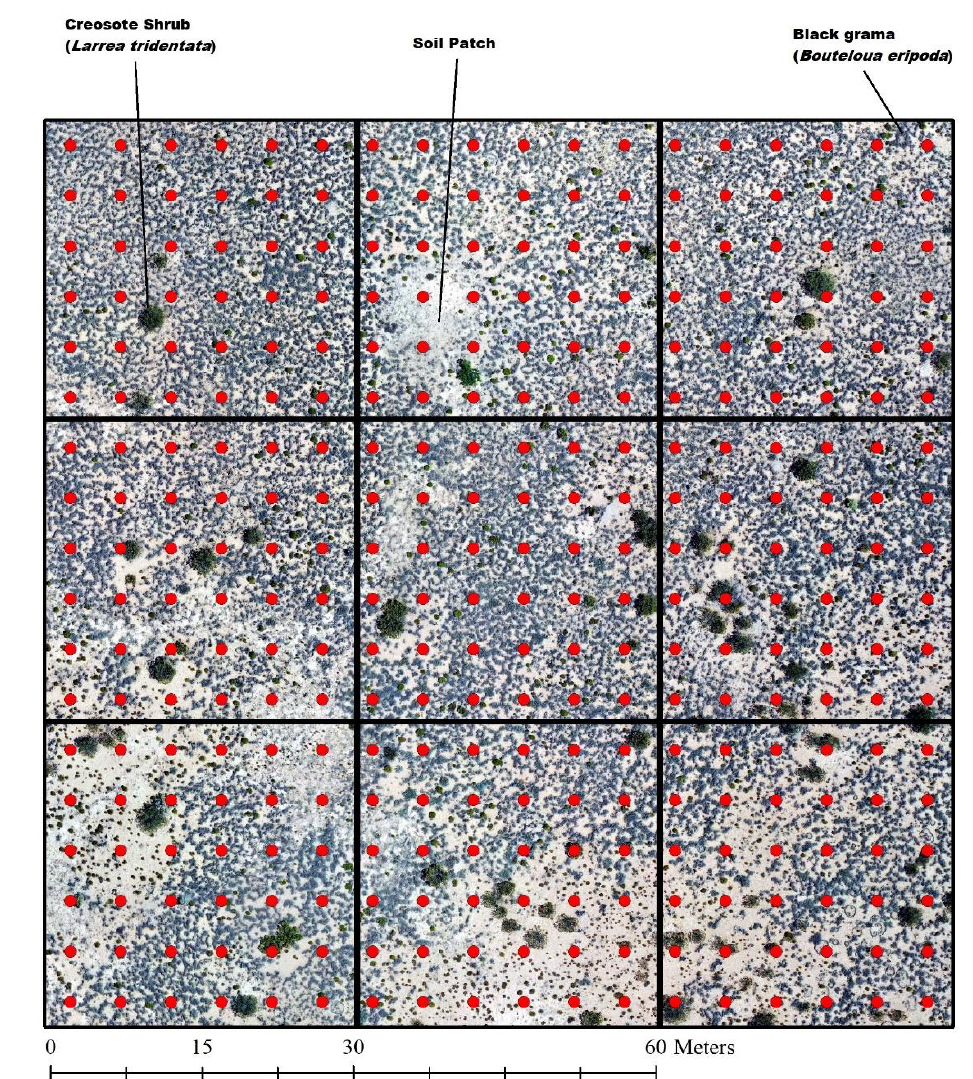
Figure 3. Sample accuracy assessment plot encompassing 90 × 90 m (nine Landsat pixels), with an 18 × 18 point grid. The cover type beneath each point was classified manually as GV, NPV, or S to yield fractional cover estimates for the plot.